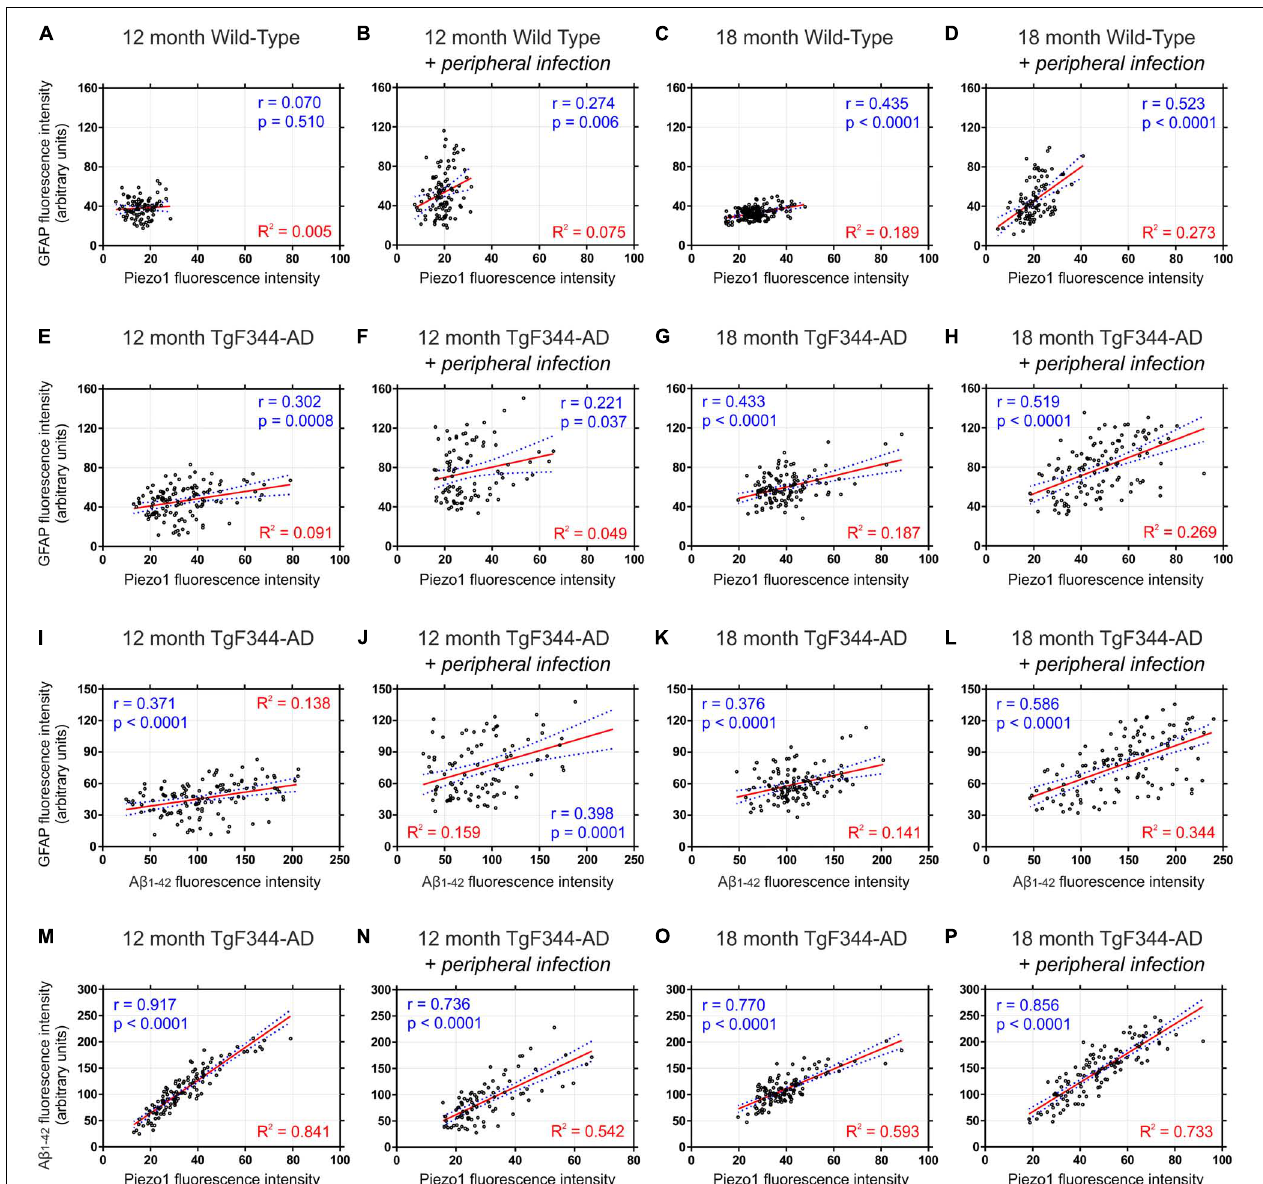
FIGURE 7 | Piezo1 expression in the hippocampal dentate gyrus correlates with GFAP in aged rats with peripheral infection and strongly correlates with amyloid plaques in TgF344-AD rats. Sagittal brain sections were triple-stained for Piezo1, GFAP and conformation-specific A β 1 − 42 and Pearson correlations ( r values) were performed to measure changes in Piezo1 channel expression in astrocytes (GFAP vs. Piezo1) with age and peripheral infection in WT (A–D) and TgF344-AD (E–H) rats. There was a moderate Pearson correlation between GFAP and Piezo1 in the infected 18-month WT ( r = 0.523) and infected 18-month TgF344-AD rats ( r = 0.519). However, the linear regression ( R 2 ) values were relatively weak for both groups suggesting that the GFAP fluorescence intensity is not a good predictor of Piezo1 channel expression. Next, Pearson correlations were performed to measure changes in GFAP expression around amyloid plaques (GFAP vs. A β 1 − 42 ) in the dentate gyrus with age and peripheral infection in TgF344-AD rats (I–L) . There was a moderate Pearson correlation between GFAP and A β 1 − 42 in the infected 18-month old TgF344-AD rats ( r = 0.586) but a relatively weak linear regression ( R 2 ) value suggesting that A β 1 − 42 fluorescence intensity is not a good predictor of GFAP expression. Finally, Pearson correlations were performed to measure changes in Piezo1 channel expression in and around amyloid plaques (A β 1 − 42 vs. Piezo1) in the dentate gyrus with age and peripheral infection in TgF344-AD rats (M–P) . There were strong Pearson correlations between A β 1 − 42 and Piezo1 in 12-month old TgF344-AD rats ( r = 0.917), 12-month old TgF344-AD rats with peripheral infection ( r = 0.736), 18-month old TgF344-AD rats ( r = 0.770), and 18-month old TgF344-AD rats with peripheral infection ( r = 0.856). In addition, the high linear regression ( R 2 ) values for each group (M–P) suggests that A β 1 − 42 fluorescence intensity is a good predictor of Piezo1 channel expression in the dentate gyrus of TgF344-AD rats.